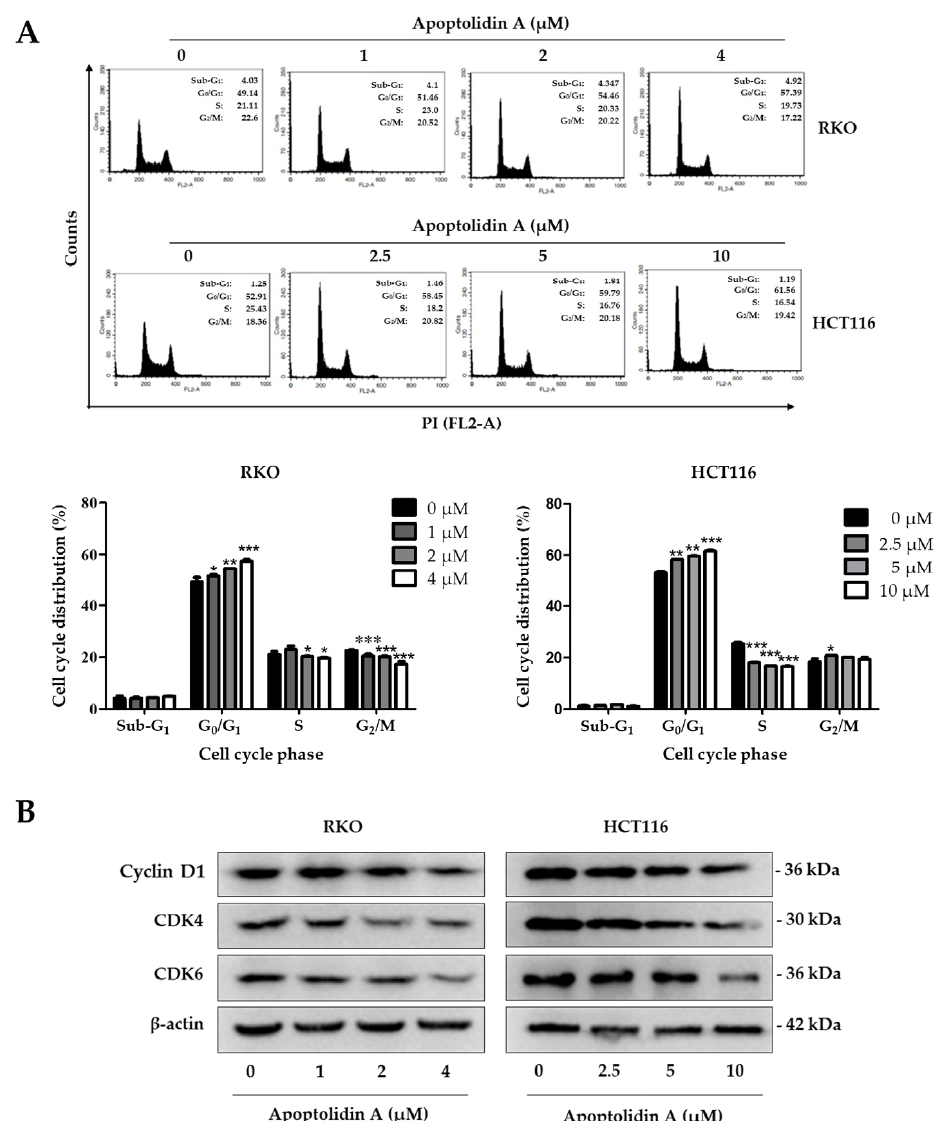
Figure 2. Effects of apoptolidin A on cell cycle regulation in CRC cells. ( A ) Induction of G 0 /G 1 cell cycle arrest in RKO and HCT116 cells after 24 h treatment of apoptolidin A. The cell cycle distribution of RKO and HCT116 cells was analyzed by flow cytometry after staining with propidium iodide (PI). Data are presented as the mean values ± SD from three independent experiments. * p < 0.05, ** p < 0.01, and *** p < 0.001 indicate statistically significant difference compared with the vehicle- treated control. ( B ) Expression of cell cycle checkpoint proteins by Western blot analysis after 24 h treatment with apoptolidin A. β -Actin was used as an internal